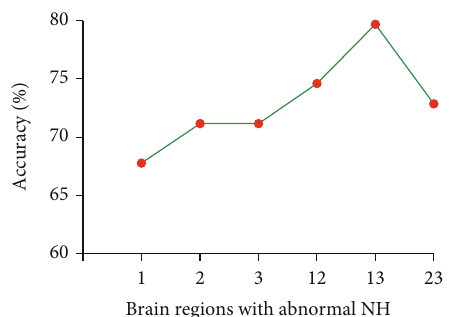
Figure 6: The accuracy of using abnormal NH values in di ff erent brain regions to classify patients. 1: left superior medial frontal gyrus; 2: right superior medial frontal gyrus; 3: left inferior temporal gyrus; 12: left superior medial frontal gyrus and right superior medial frontal gyrus; 13: left superior medial frontal gyrus and left inferior temporal gyrus; 23: right superior medial frontal gyrus and left inferior temporal